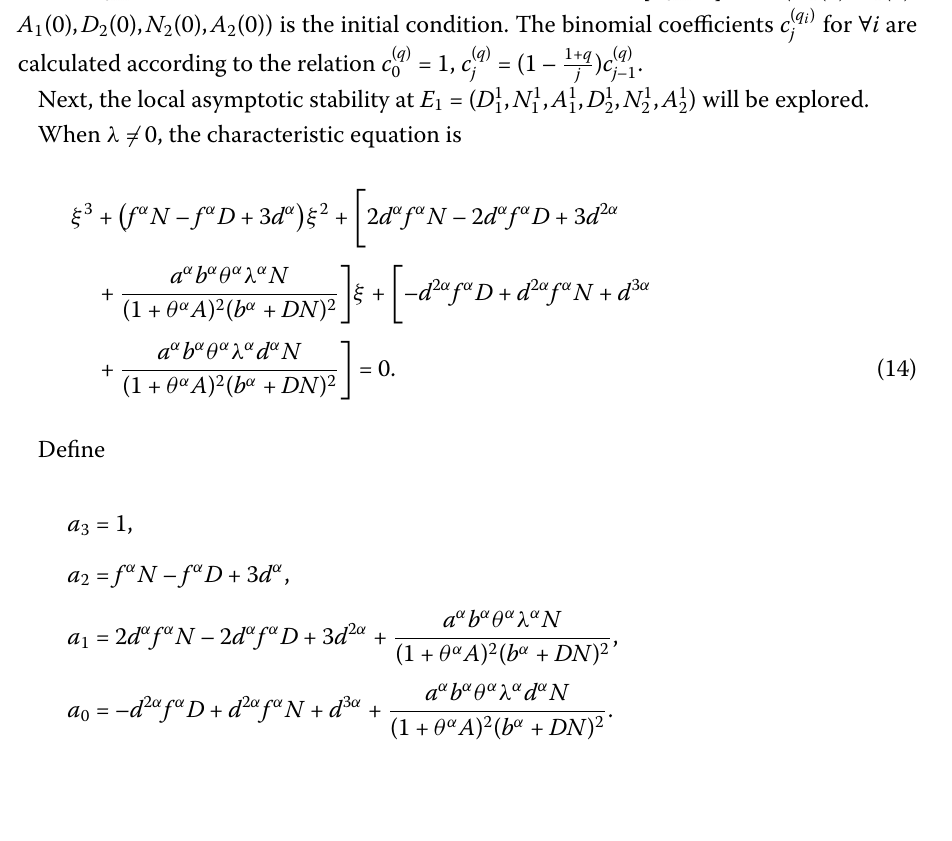
where T sim is the simulation time, k = 1,2,3,..., N , for N = [ T sim / h ], and ( D 1 (0), N 1 (0), A 1 (0), D 2 (0), N 2 (0), A 2 (0)) is the initial condition. The binomial coefficients c ( q i ) calculated according to the relation c ( q )